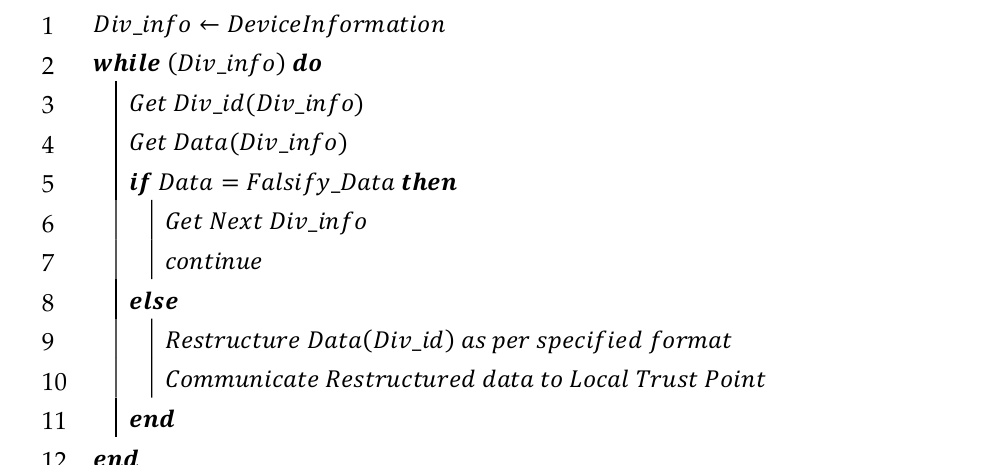
Algorithm 2: Local Fog Node Data Filtering and Preprocessing.